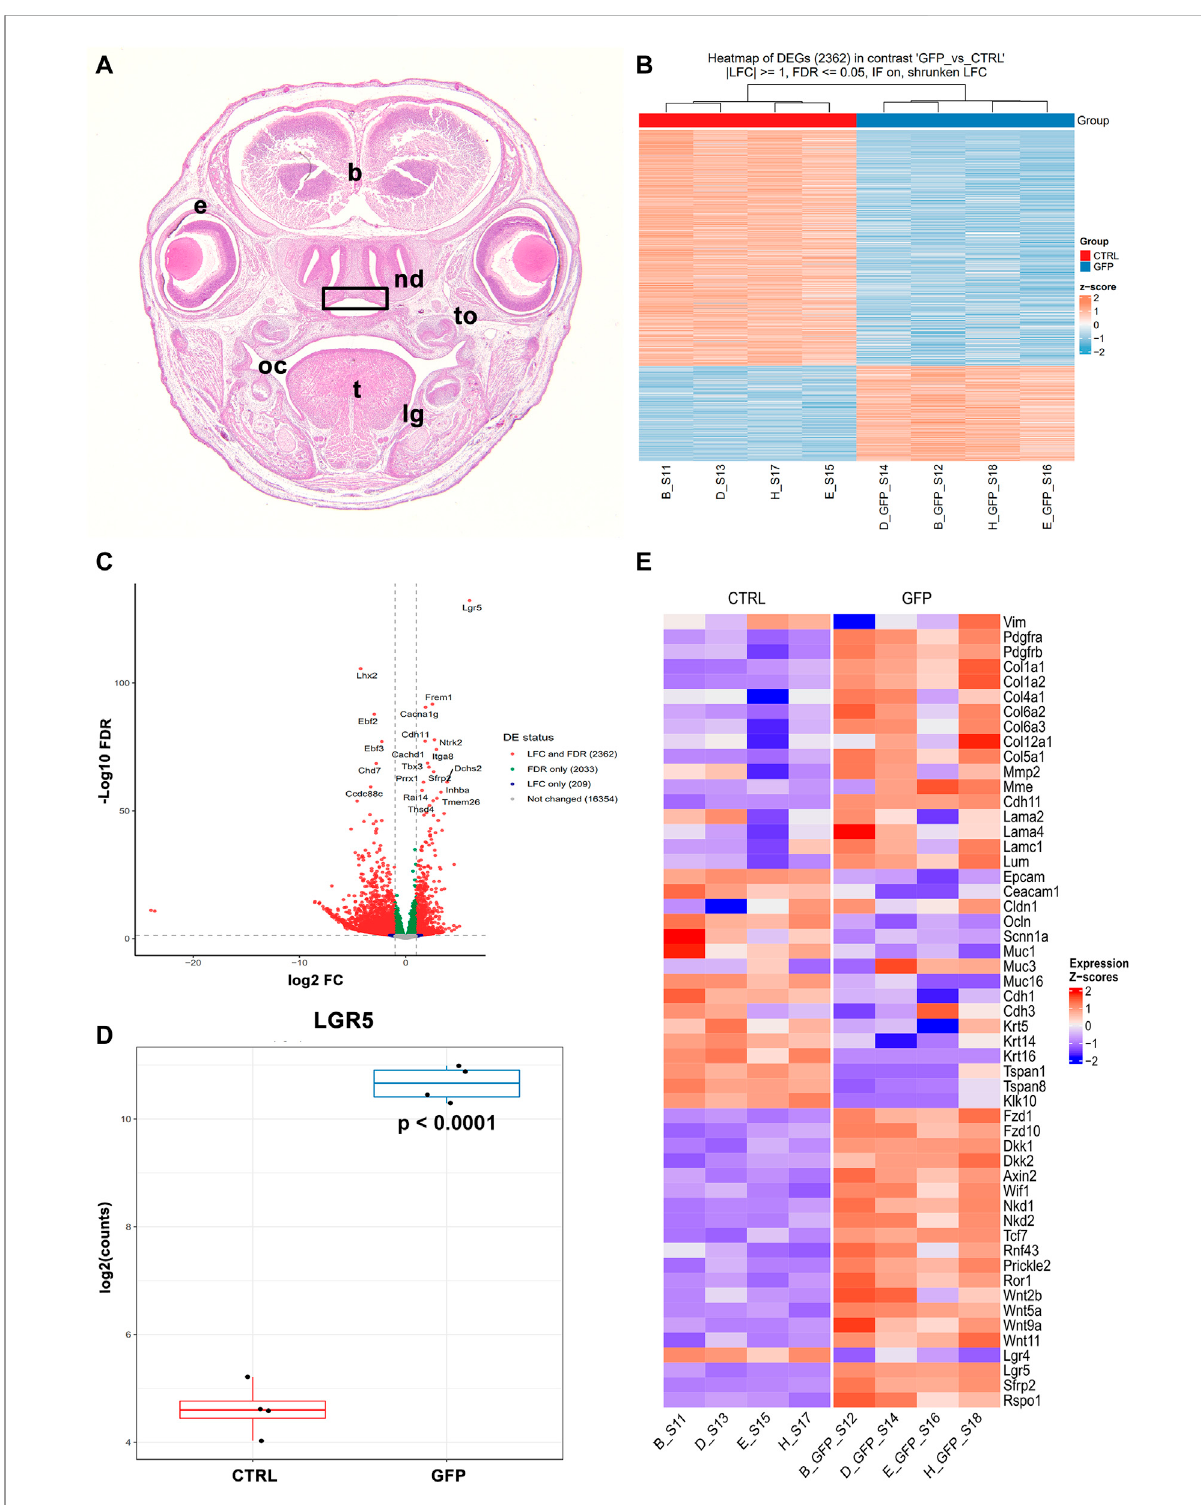
FIGURE 13 Gene expression pro fi le of LGR5-positive and LGR5-negative cells by RNA sequencing. (A) Roof of nasopharyngeal area (rectangle) was collected from animals Lgr5 +/ − mice at E16.5 as shown of transversal section through the head stained by Hematoxylin-Eosin. (B) LGR5/EGFP- positive and LGR5/EGFP-negative cells were sorted and analyzed separately. Four samples were used for each cell populations and these samples exhibit high similarity as shown on heat map. 2362 genes exhibited statistically signi fi cance between groups. (C) Volcano plot of signi fi cantly